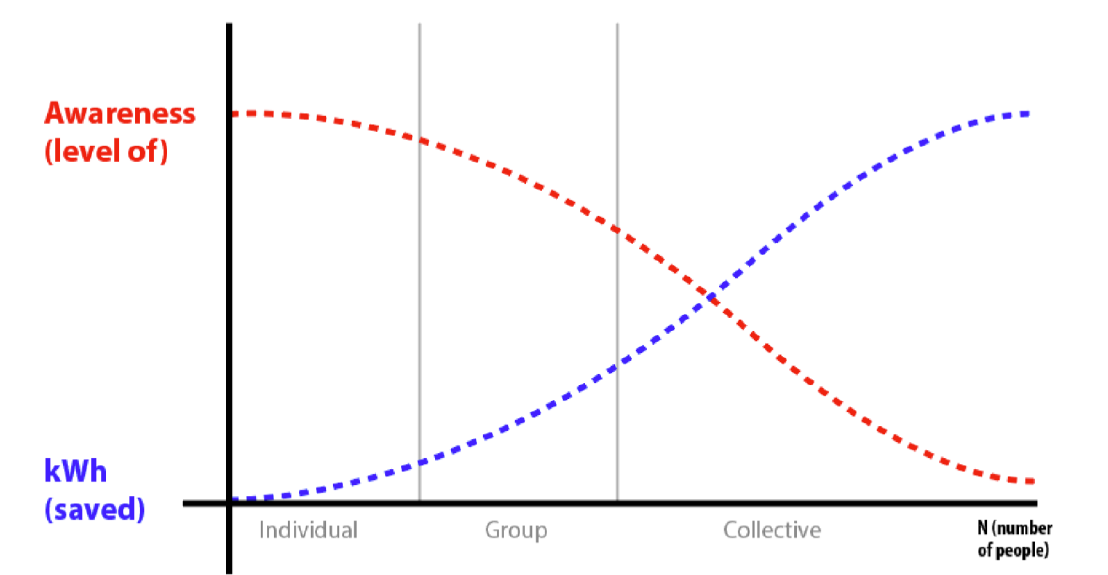
Figure 2. The GreenSoul phases: Individual where motivation is high but the effect on energy efficiency and reduction is low. Collective, where the motivation of users to embark on campaigns might be low, but the potential of the energy savings is